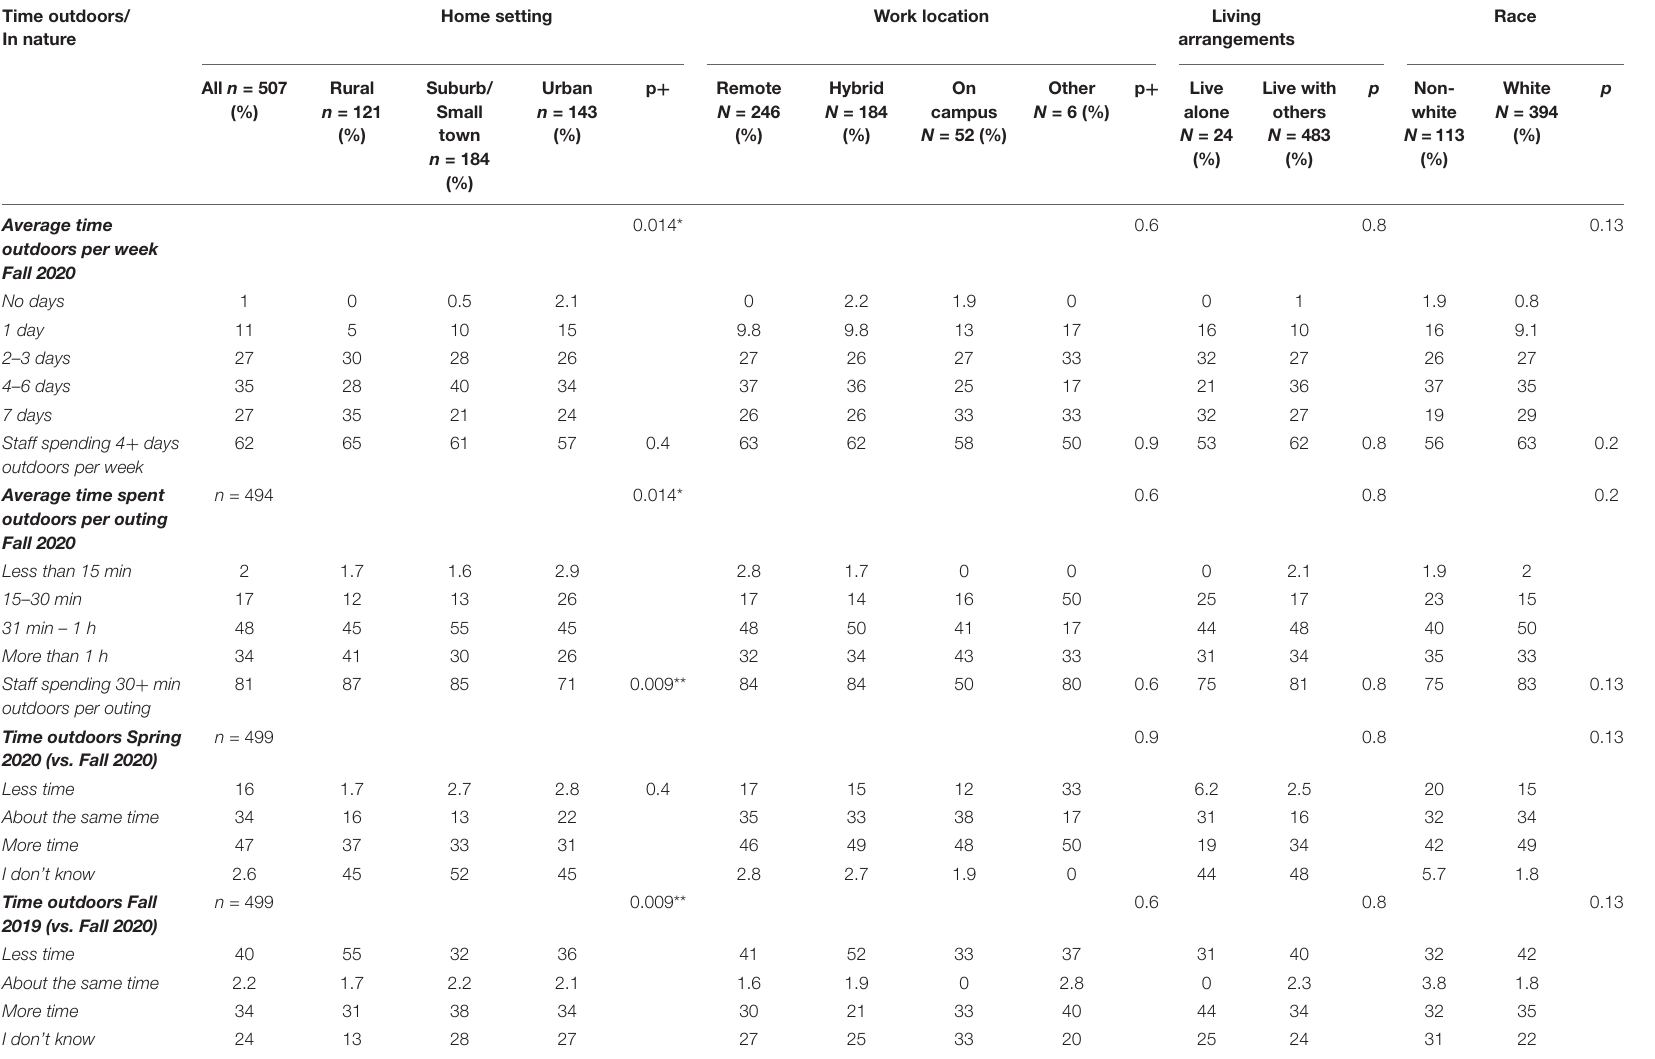
Home setting Work